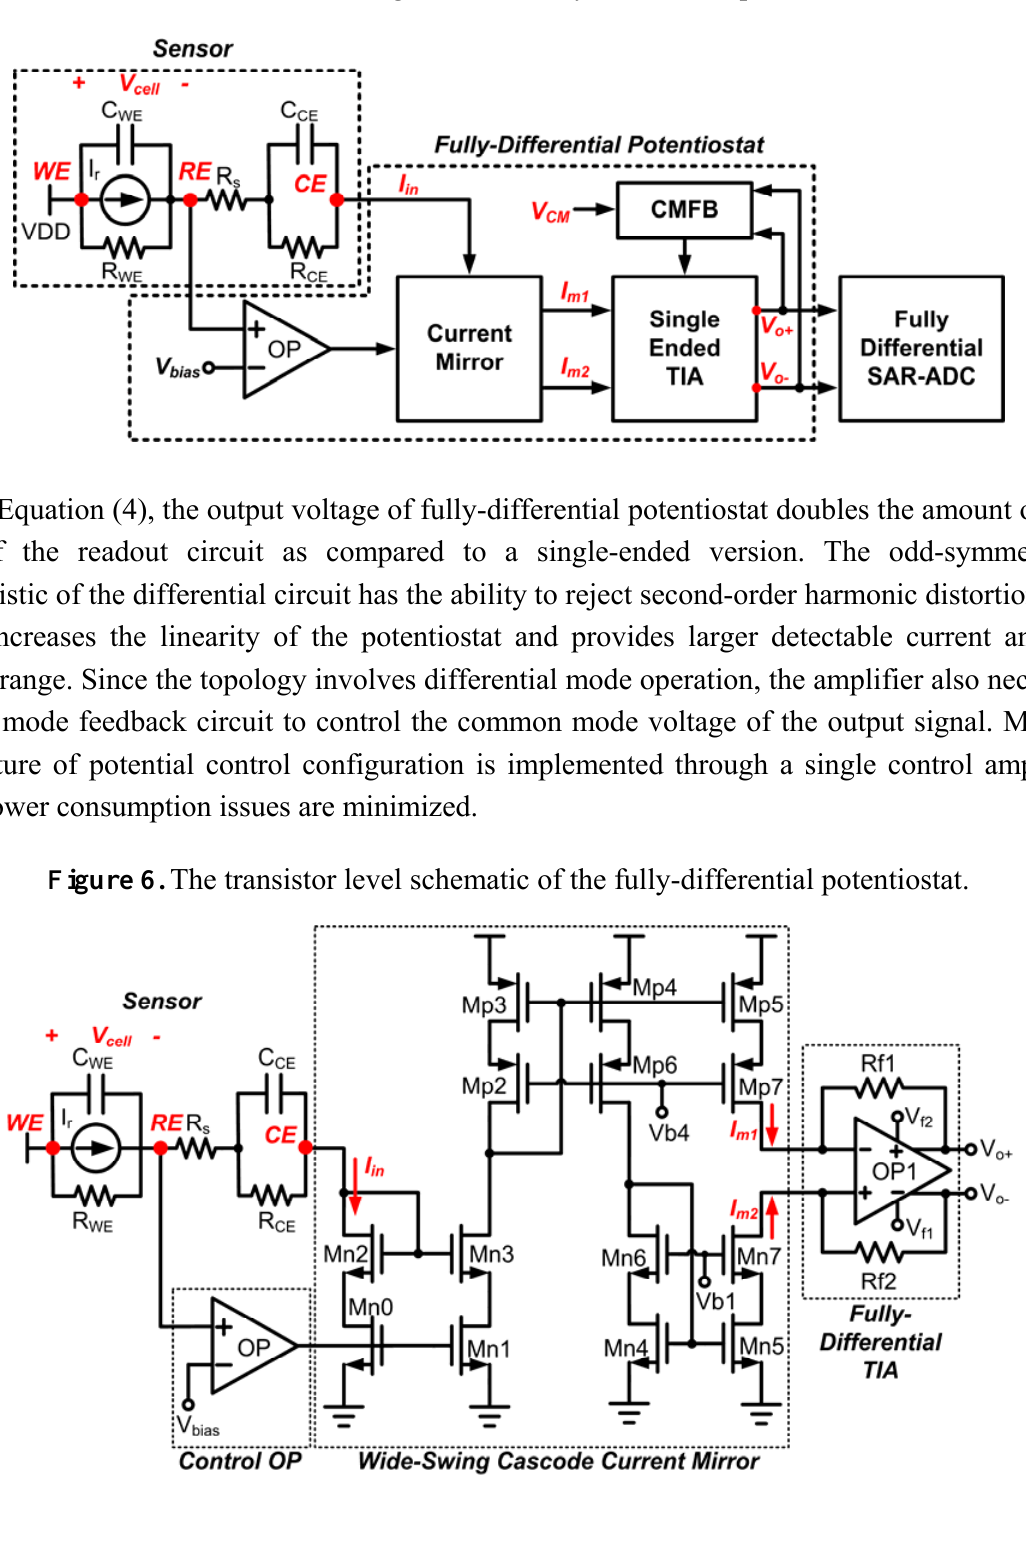
Figure 5. The building blocks of fully-differential potentiostat.